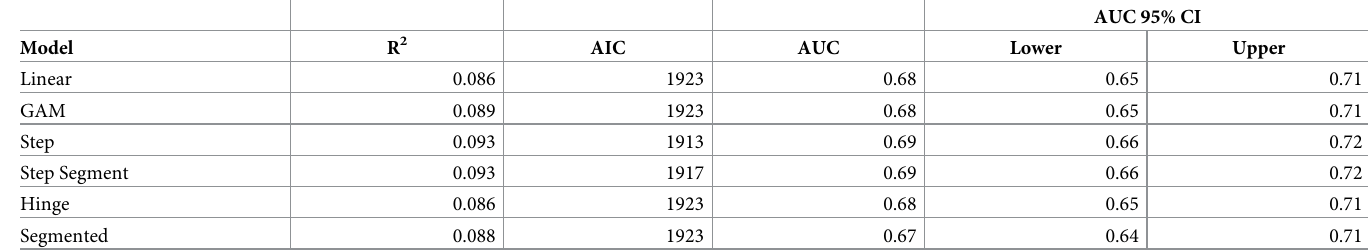
Table 3. Comparison of model fit statistics: Nagelkerke‘s Rs, Akaike Information Criterion (AIC), and the Area Under the Curve (AUC).